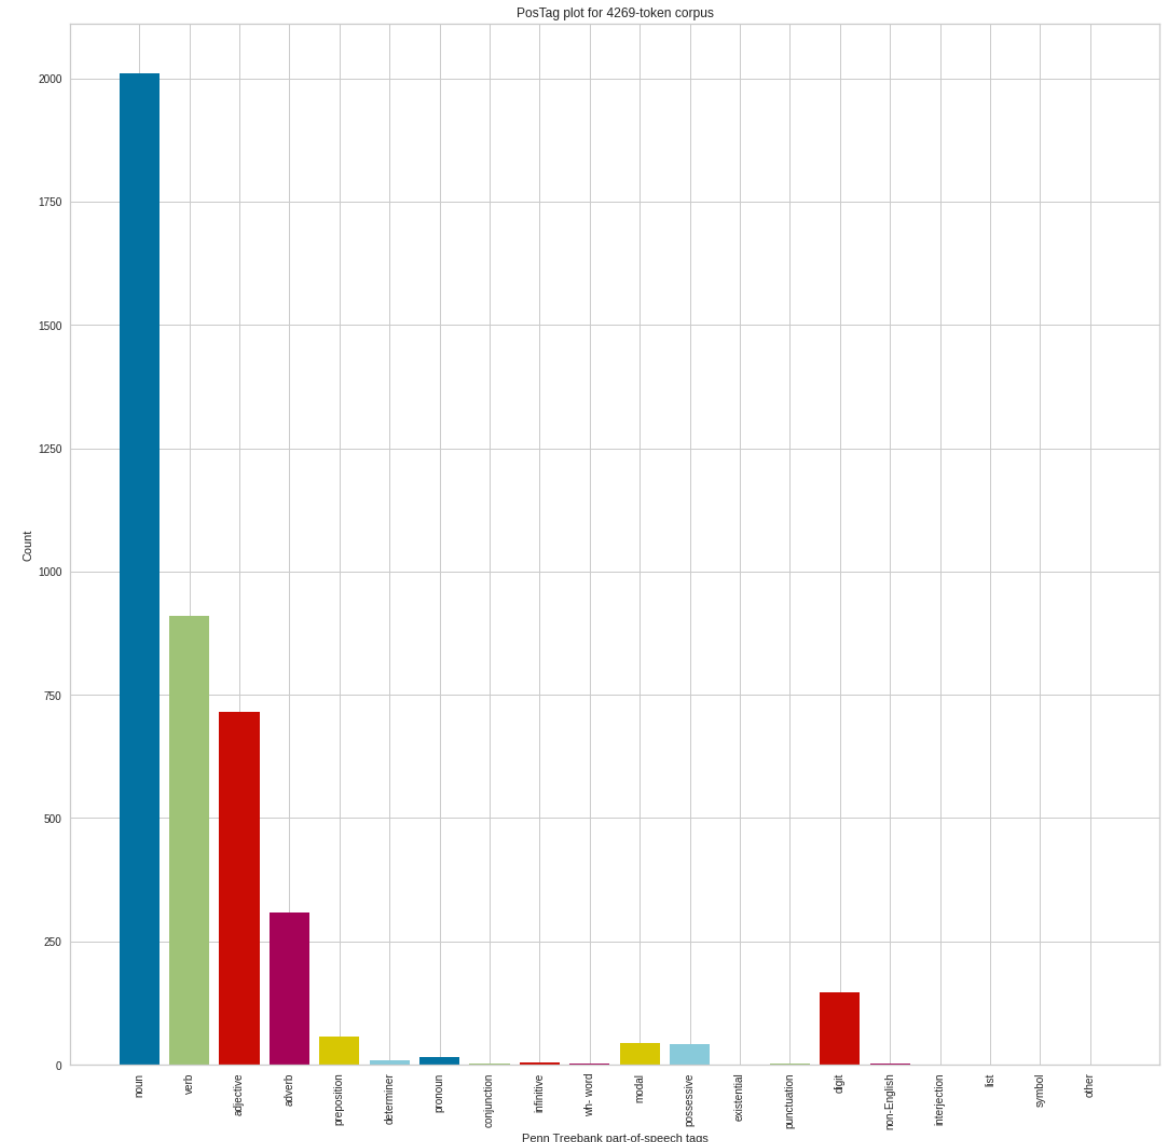
Figure 10. Part of speech tagging for negative tweets. The time period stands between 29 August 2021 and 31 August